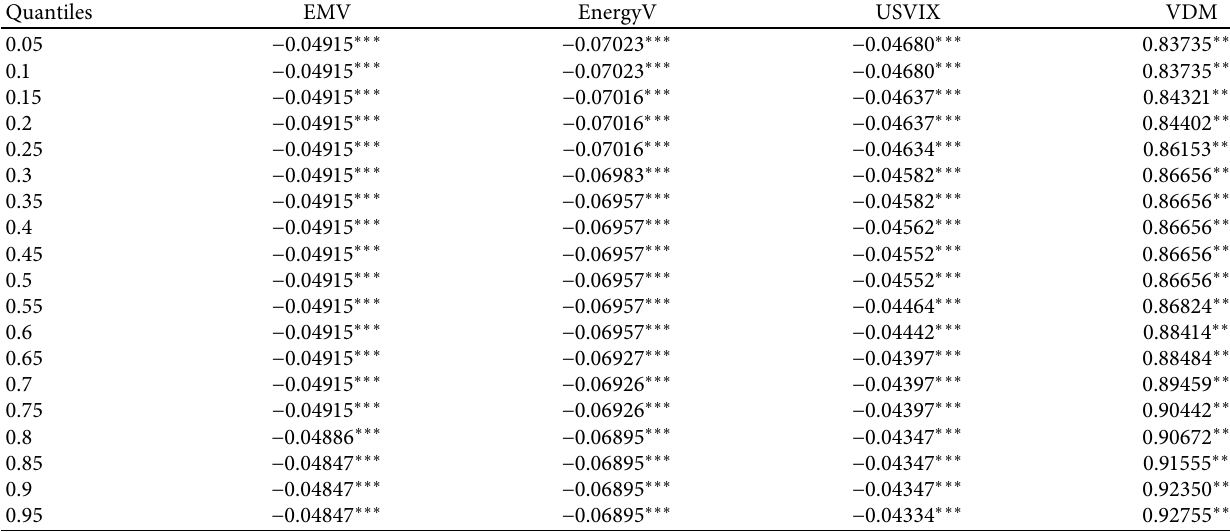
Table 5: Effect of volatilities on DJIMEI.